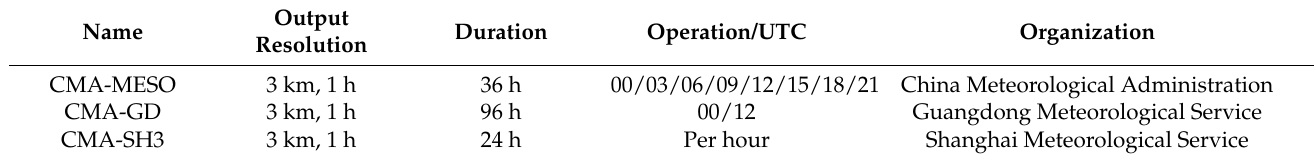
Figure 1. Domains of three different models and the location of Hunan Province (red line) in the Lambert map projection. Table 1. Three high temporal-spatial resolution numerical weather prediction models.